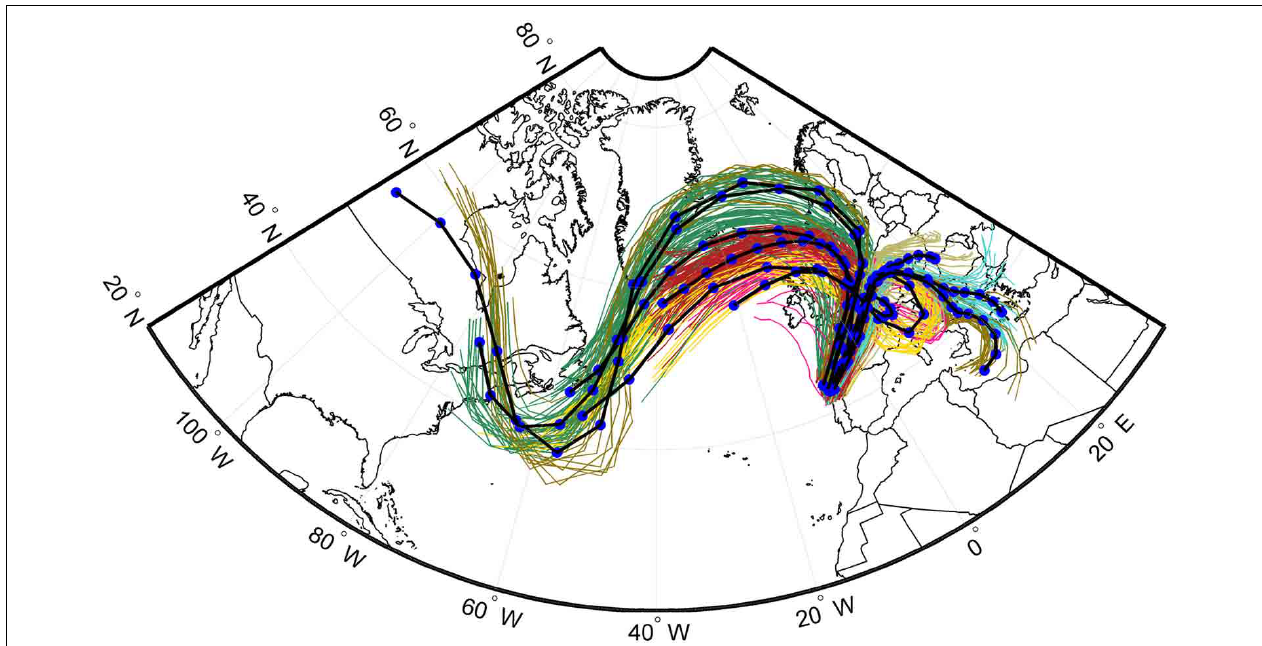
FIGURE 2 | Backward trajectories (90h) arriving to the northwest Iberia Peninsula (41 ◦ N–44.5 ◦ N and 10 ◦ W–6 ◦ W) on a particular day (11/11/1999—12 UTC) in color lines and the respective clusters position (blue dots) computed by the Dorling method (dark lines).